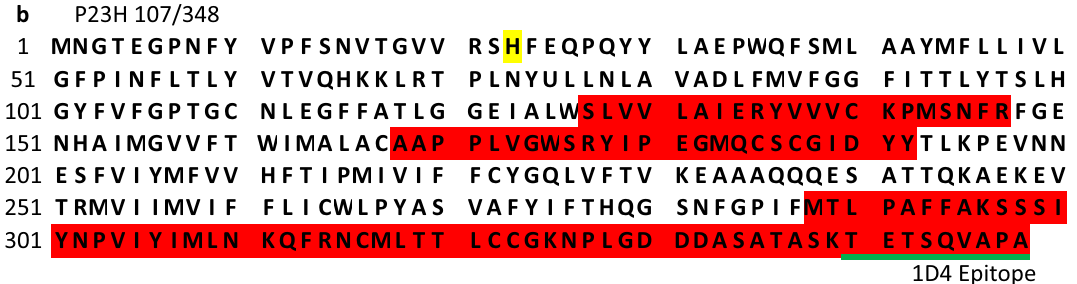
mechanisms, ERAD and autophagy, have been implicated in P23H rhodopsin protein turnover in the retina 19,36 . To determine if these protein quality control mechanisms were present in the P23H rhodopsin protein interac- tome, we performed bioinformatic pathway analysis on our P23H and wild-type rhodopsin mass spectrometry datasets. We used gProfiler (https:// biit. cs. ut. ee/ gprofi ler/) 50 to analyze our wild-type and P23H rhodopsin pro- tein lists across four different gene/protein function annotation databases (Supplementary Information S4 and S5): Gene Ontology Biological Processes (GO-BP) 51 ; Reactome 52 ; GO Molecular Functions (GO-MF) 51 ; and Kyoto Encyclopedia for Genes and Genomes (KEGG) 53 .